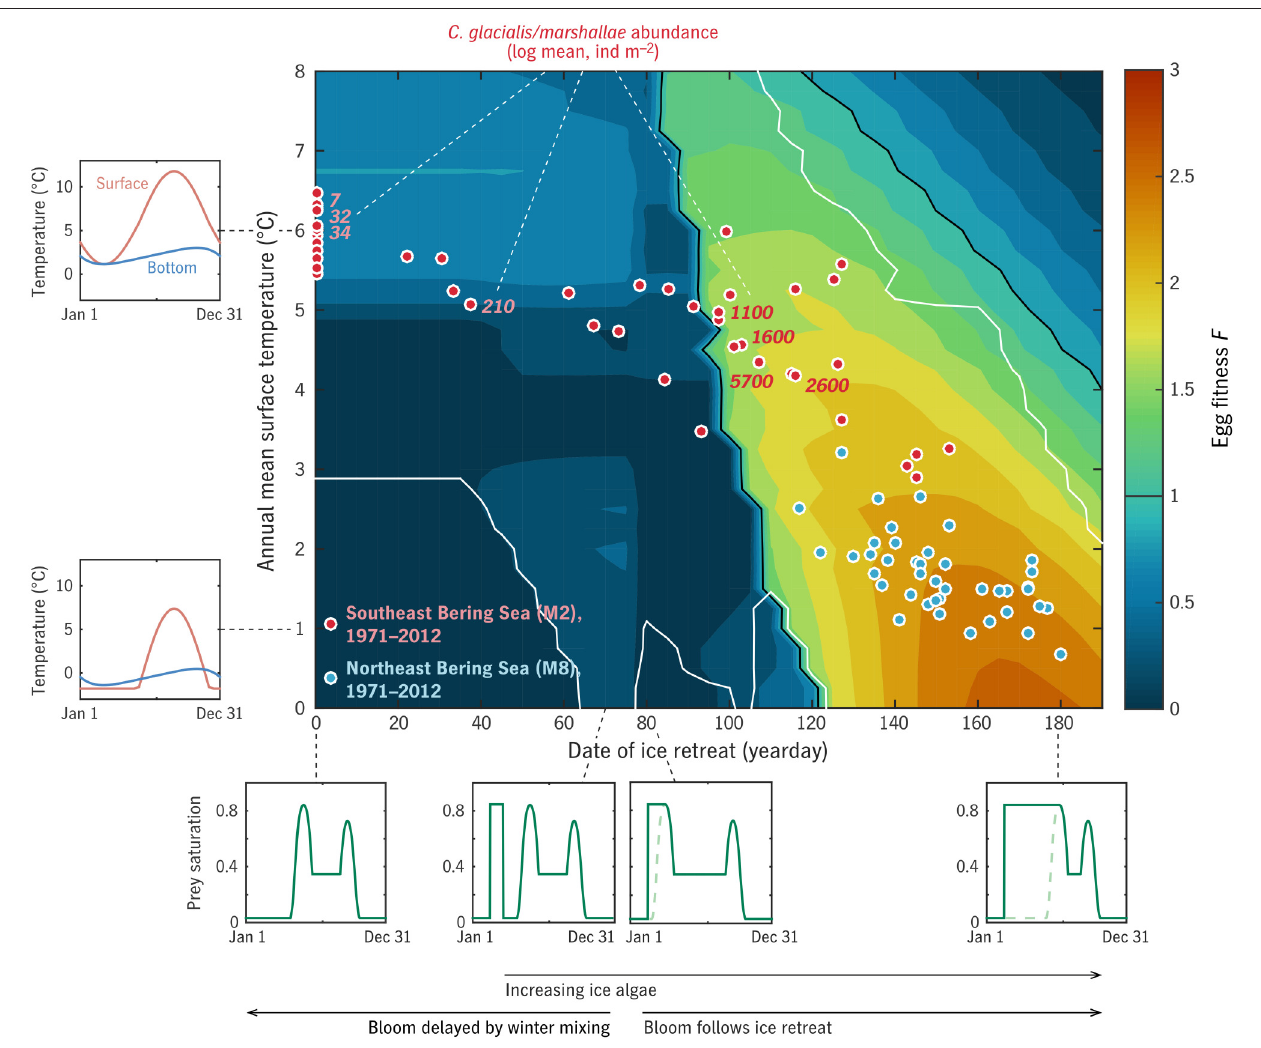
FIGURE 7 | Results of the “Bering” experiment. Color contours give the predicted egg fitness of a C. glacialis/marshallae analog under combinations of ice retreat timing (assumed to control spring bloom timing: Appendix in Supplementary Material) and temperature. Examples of the annual cycles of prey availability P and surface and bottom temperature T 0 , T d are given at left and bottom. Dots locate years 1971–2012 in this timing/temperature parameter space, for the northern (blue) and southern (red) middle shelf. Numbers beside red dots give the measured summer abundance of C. glacialis/marshallae on the southern shelf across years. White contours give the bounds of the central region within which Coltrane predicts one generation per year to be the optimal generation length.